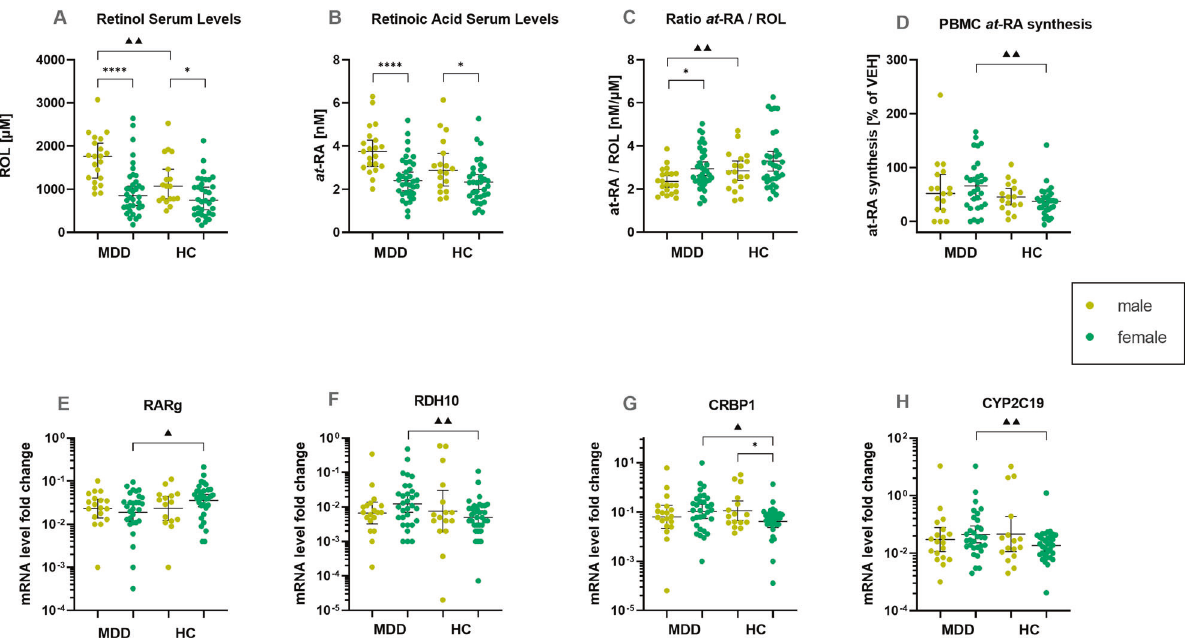
Fig. 2 Gender differences in retinoid homeostasis parameters. * marks signi fi cant within-group gender differences (i.e., male vs female in MDD or HC). ▲ marks signi fi cant group differences for within-gender comparisons (i.e., female MDD vs female HC) A ROL serum levels. B at -RA serum levels. C the ratio of at -RA to ROL. D at -RA synthesis activity in PBMC. E – H Gene transcription of retinoid pathway-related genes in PBMC, fold change values presented as the 2 − Δ Ct . Error bars depict the median ( A – D ) or geometric mean ( E – H ) with 95% CI. t -tests were used for group